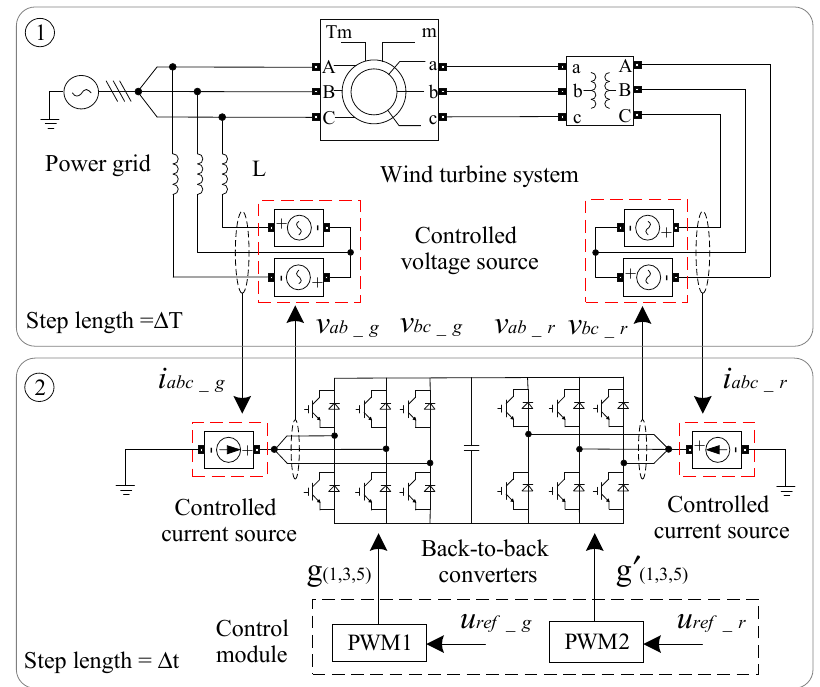
Figure 4. Principle diagram of decoupling system with different step lengths.